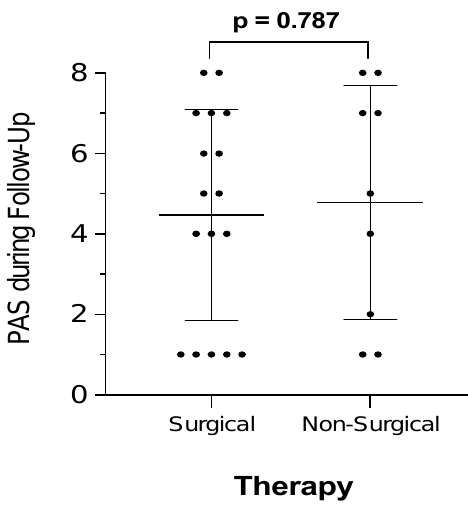
Figure 2. PAS score and therapy . Penetration-Aspiration-Scales (PAS) were available in 26 patients within follow-up. Patients were dichotomized into those who received surgical therapy, including surgery and radiotherapy (RT) or chemoradiotherapy (CRT), compared to patients who underwent non-surgical therapy, such as primary RT or CRT. Mean ± 95% Confidence-Intervals are indicated.